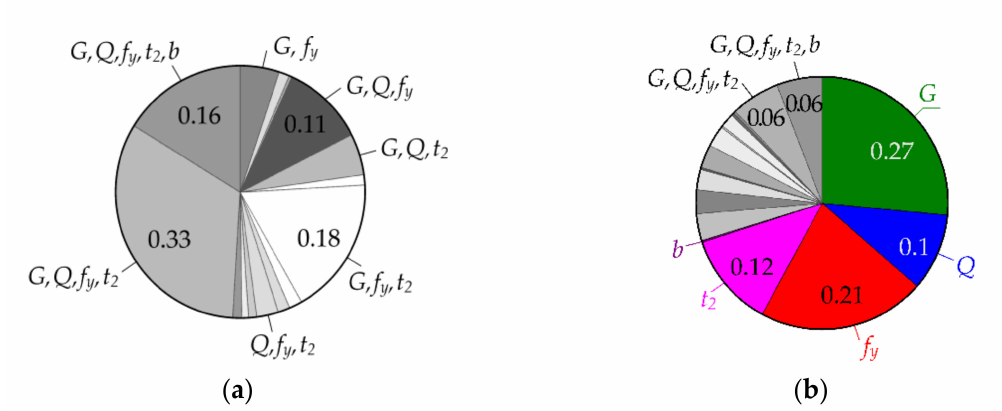
Figure 12. The results of SA for P f = 8.5 × 10 − 6 using: ( a ) C M ( P f ), Equation (23); ( b ) E M ( P f ), Equation (25).